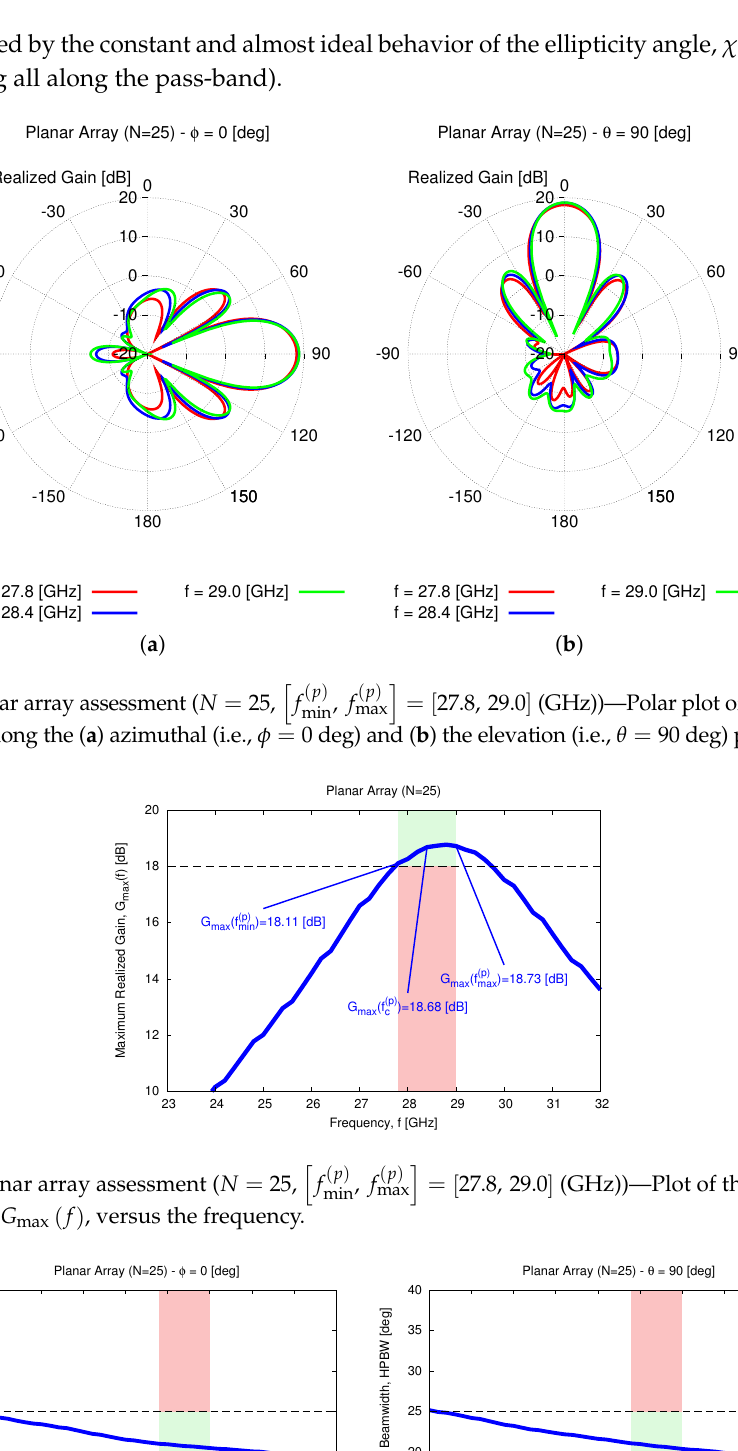
(cid:104) (cid:105) ( p ) ( p ) = [ 27.8, 29.0 ] [GHz])—Plot of the HPBW f , f max min